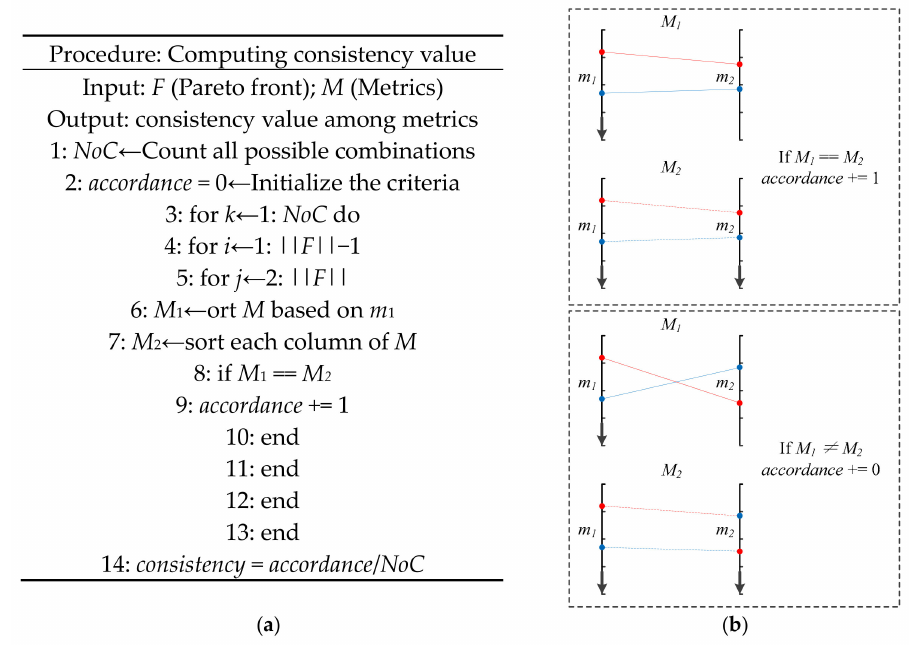
Figure 2. Schematic of calculating the consistency value. ( a ) Pseudo-code for computing consistency; ( b ) Judging of relationship between data